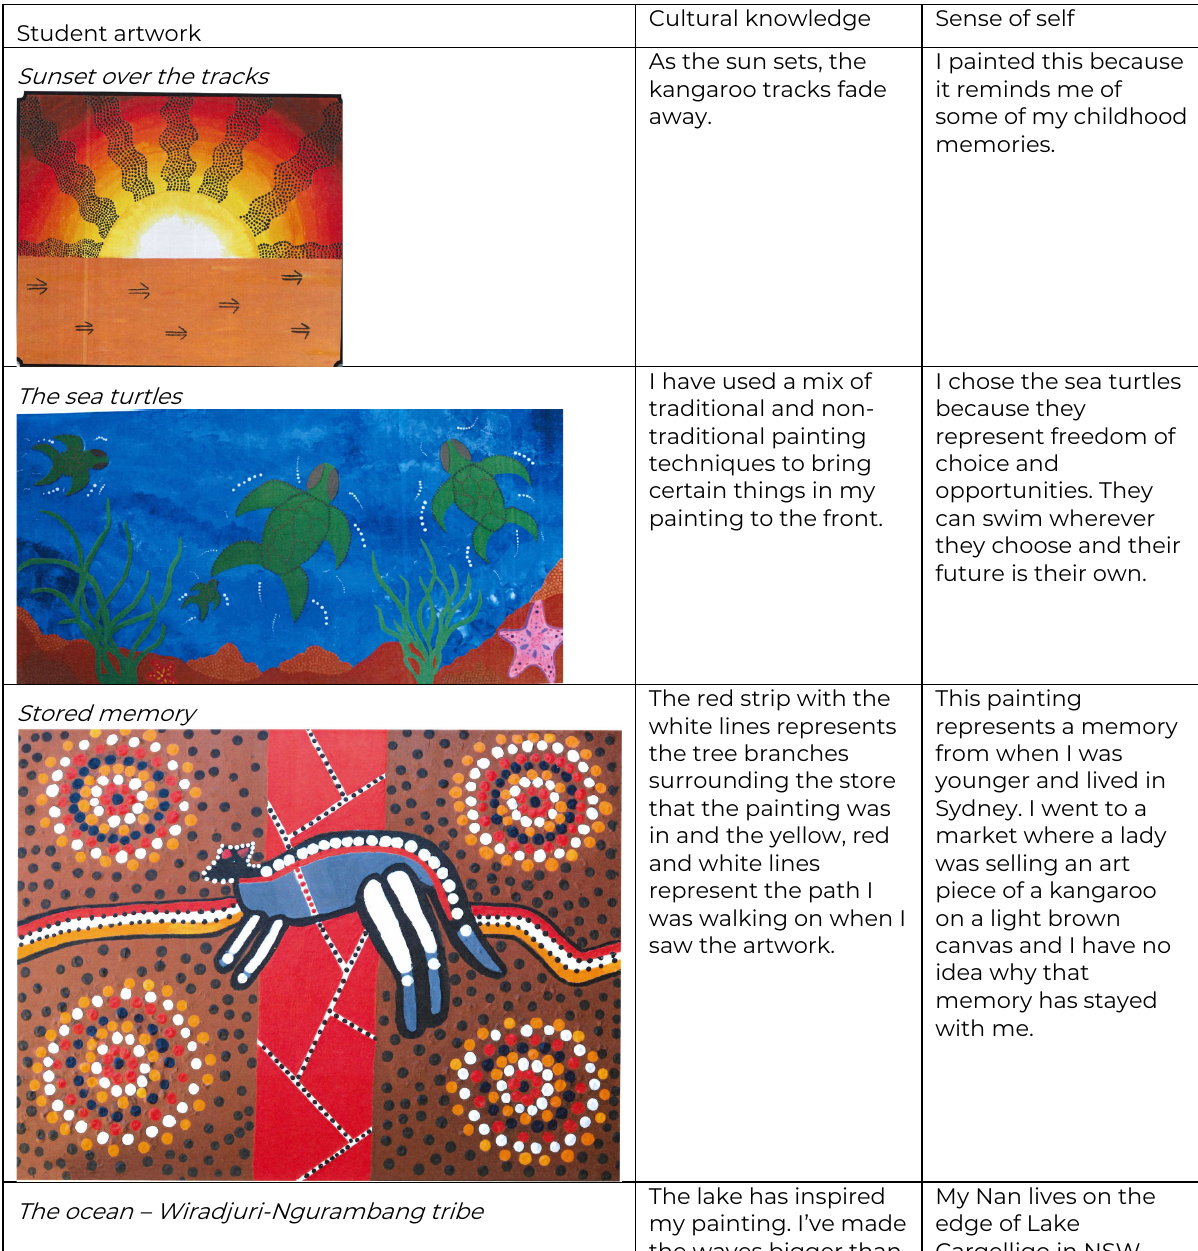
Table 1. Examples of ePortfolio content created by